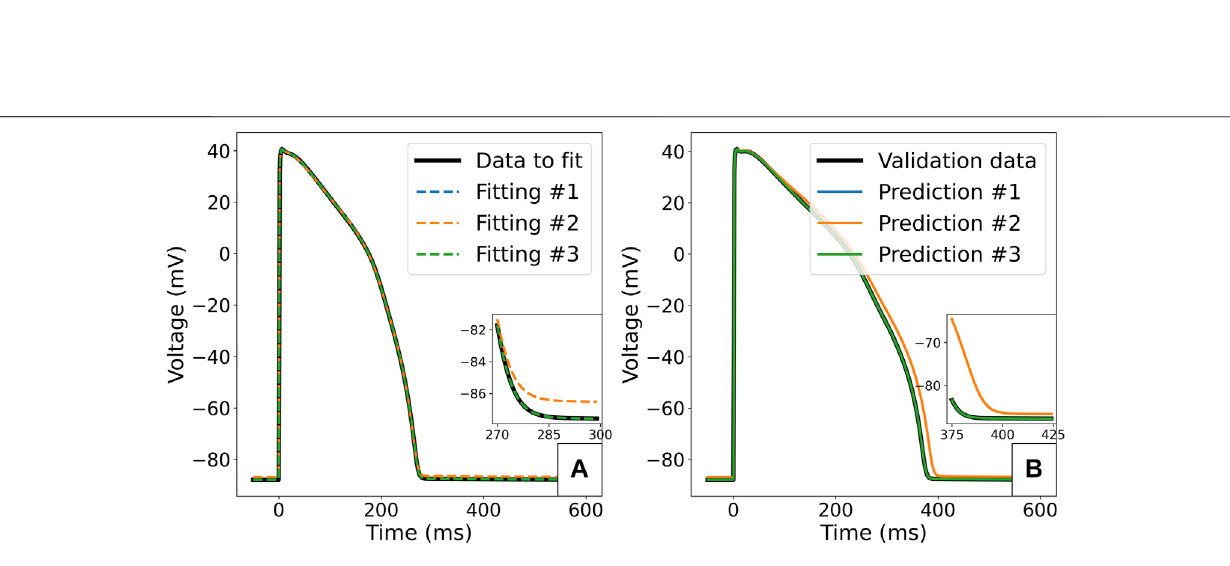
FIGURE8| PredictedAPsfortheORd-CiPAmodel fi ttedtosyntheticdata. (A) ComparisonofthesyntheticdatawithAPsobtainedfromoptimalparameterisations in the different fi tting cases. (B) Prediction of response of the model to 50% block of I Kr . Predictions of model with parameter fi ttings #1, #3 and the true parameters set